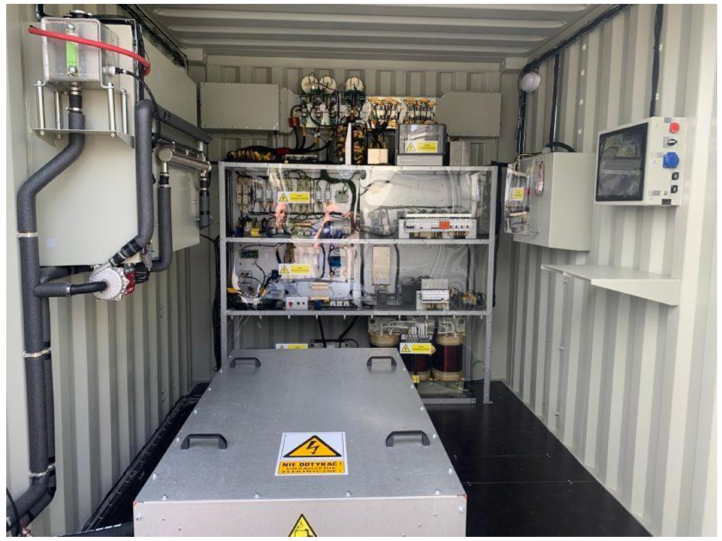
Figure 5. DC/AC converter for conversion converting trolleybus 600 V DC overhead line voltage